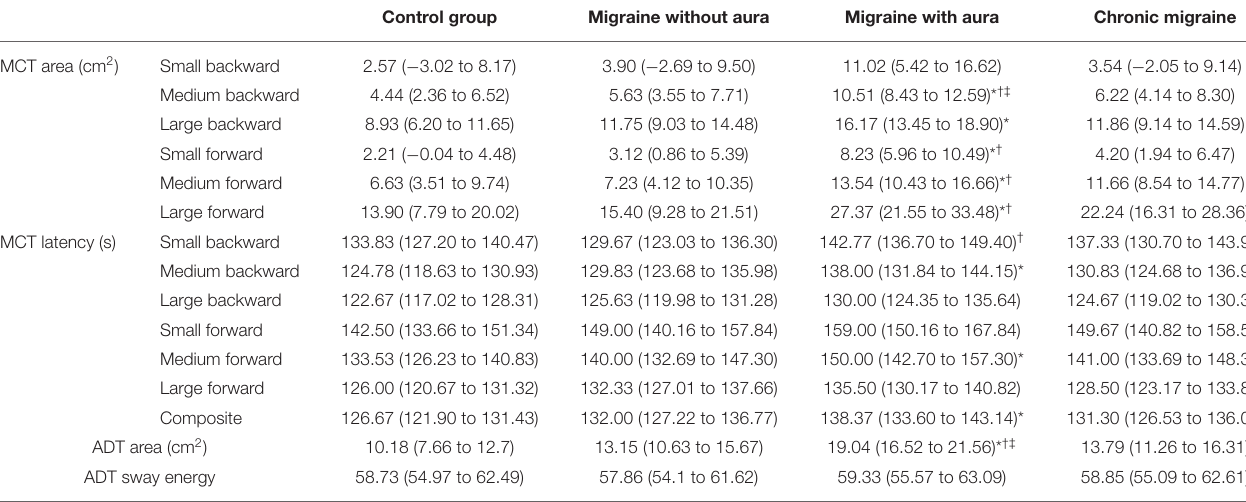
TABLE 2 | Mean and 95% CI of sway area and latency during the motor control test (MCT) and adaptation test (ADT) among migraine groups and controls.